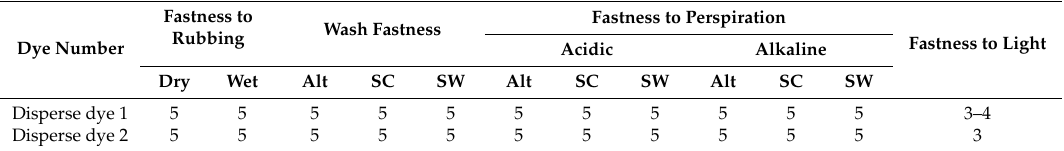
Table 2. Fastness properties of the polyethylene terephthalate fabrics dyed with disperse dyes 1 and 2 by utilizing the eco-friendly carrier.